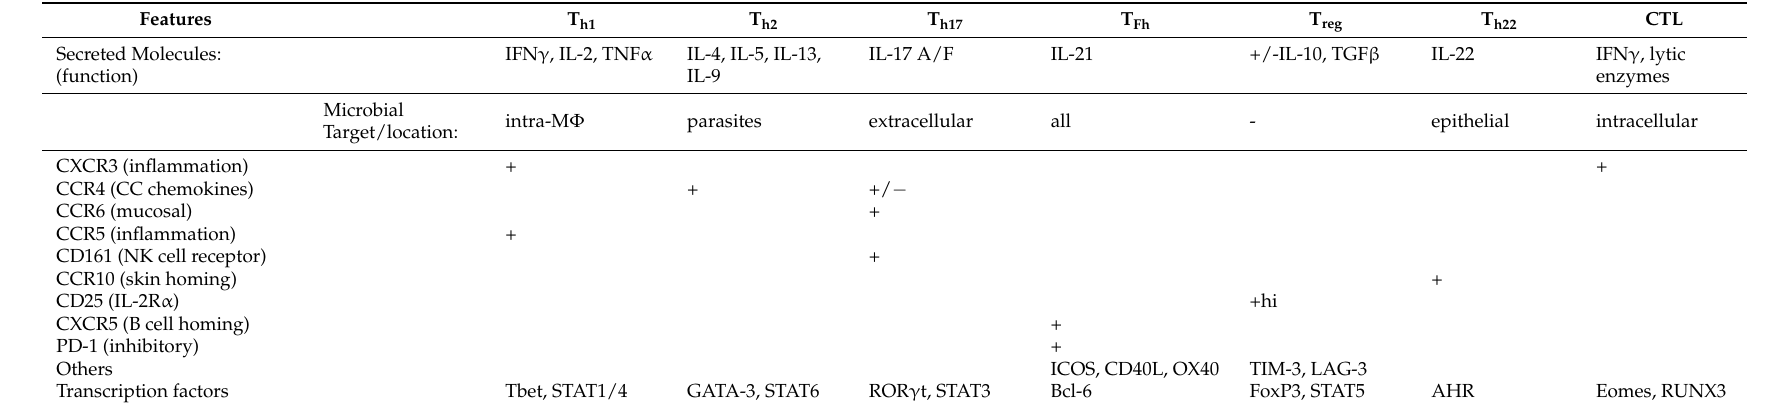
Table 1. Effector T cell phenotypes (canonical markers, not exhaustive or mutually